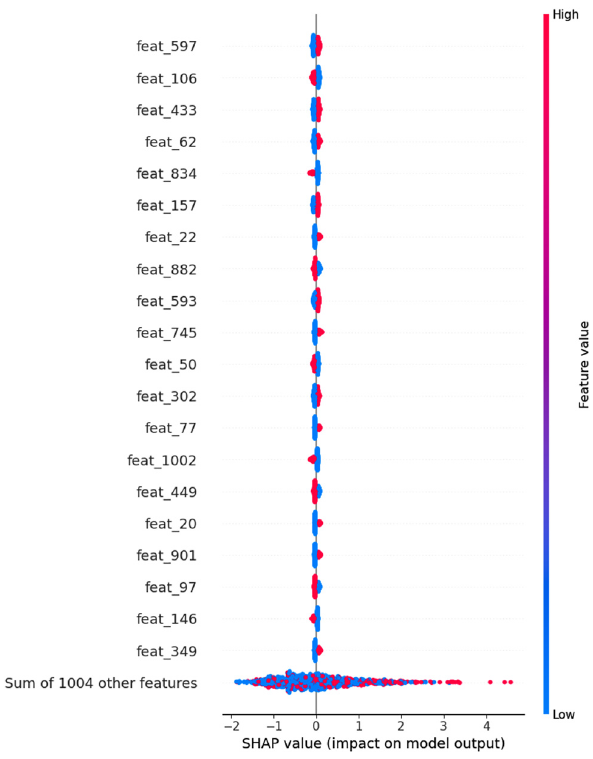
Figure 7: Global feature importance for the AtomPair modeltrainedontheCCRF-CEMdataset.Onlythe20most important features are shown, and features are ordered according to their importance. Each point represents a sample in the test set, and the color of the points represents the value of a particular feature for that